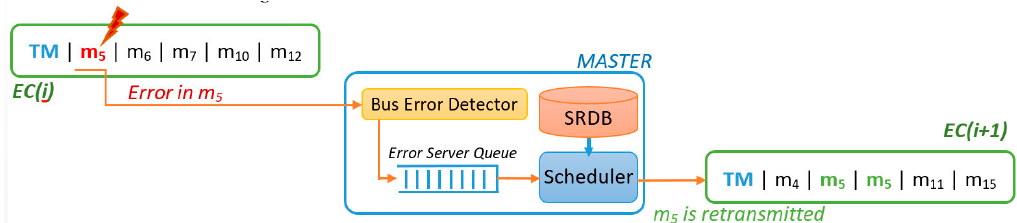
Figure 3 . Error recovery process. Figure 3. Error recovery process.